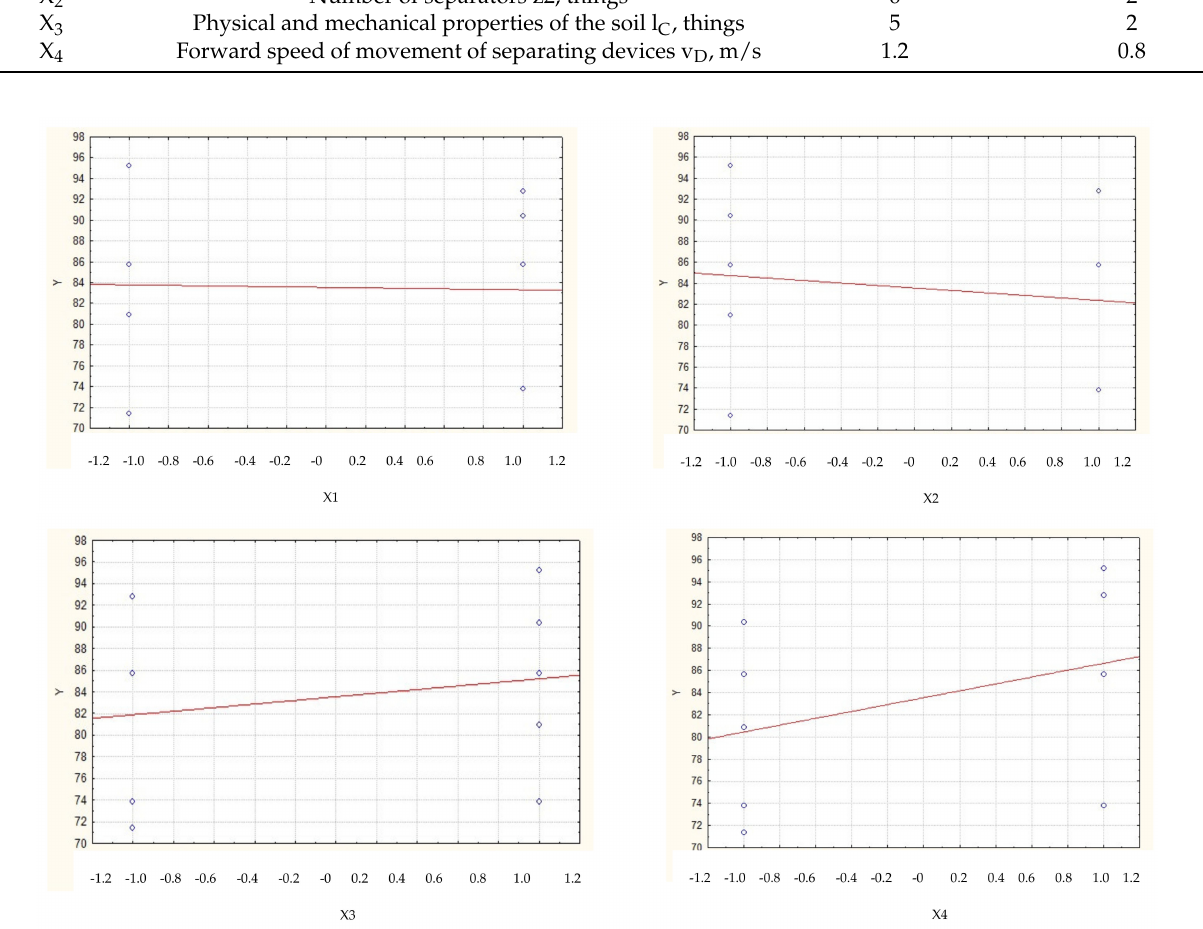
Figure 14. Scatter plots of levels of factors of the screening experiment.